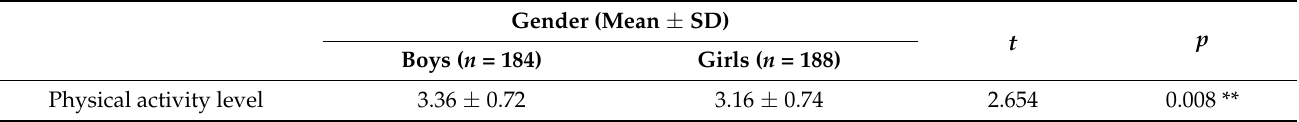
Table 3. t -test analysis results.